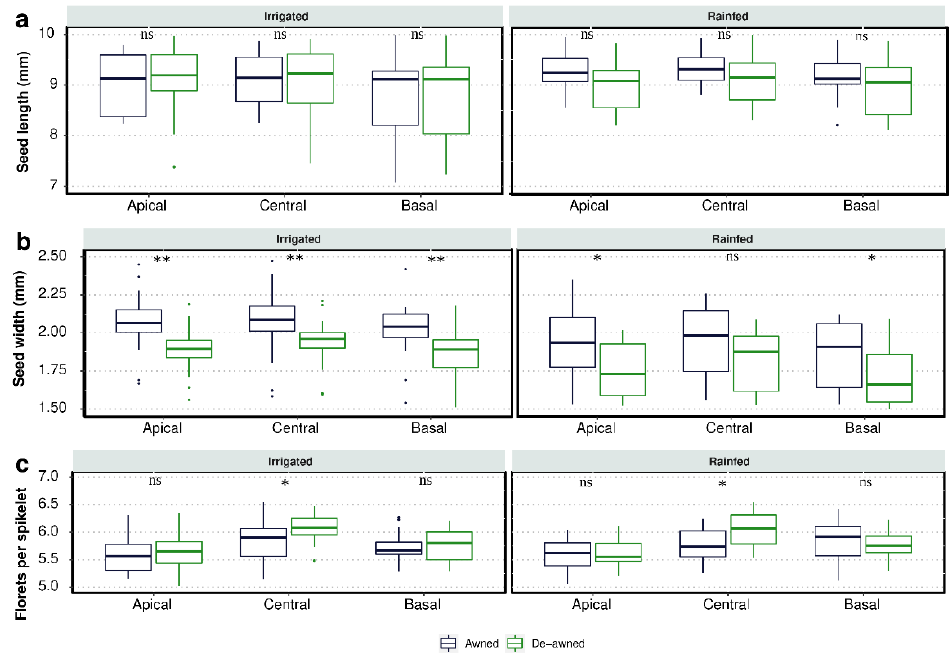
Figure 4. Box plots summarizing seed length ( a ), seed width ( b ), and florets per inflorescence ( c ) in the apical, central, and basal spikelets of the spikes. ns: not significant, * p < 0.05, ** p < 0.01. Each box plot denotes the average of 10 accessions for corresponding traits. The significances indicate the comprehensive effect of awn excision on different traits of 10 Siberian wildrye accessions.